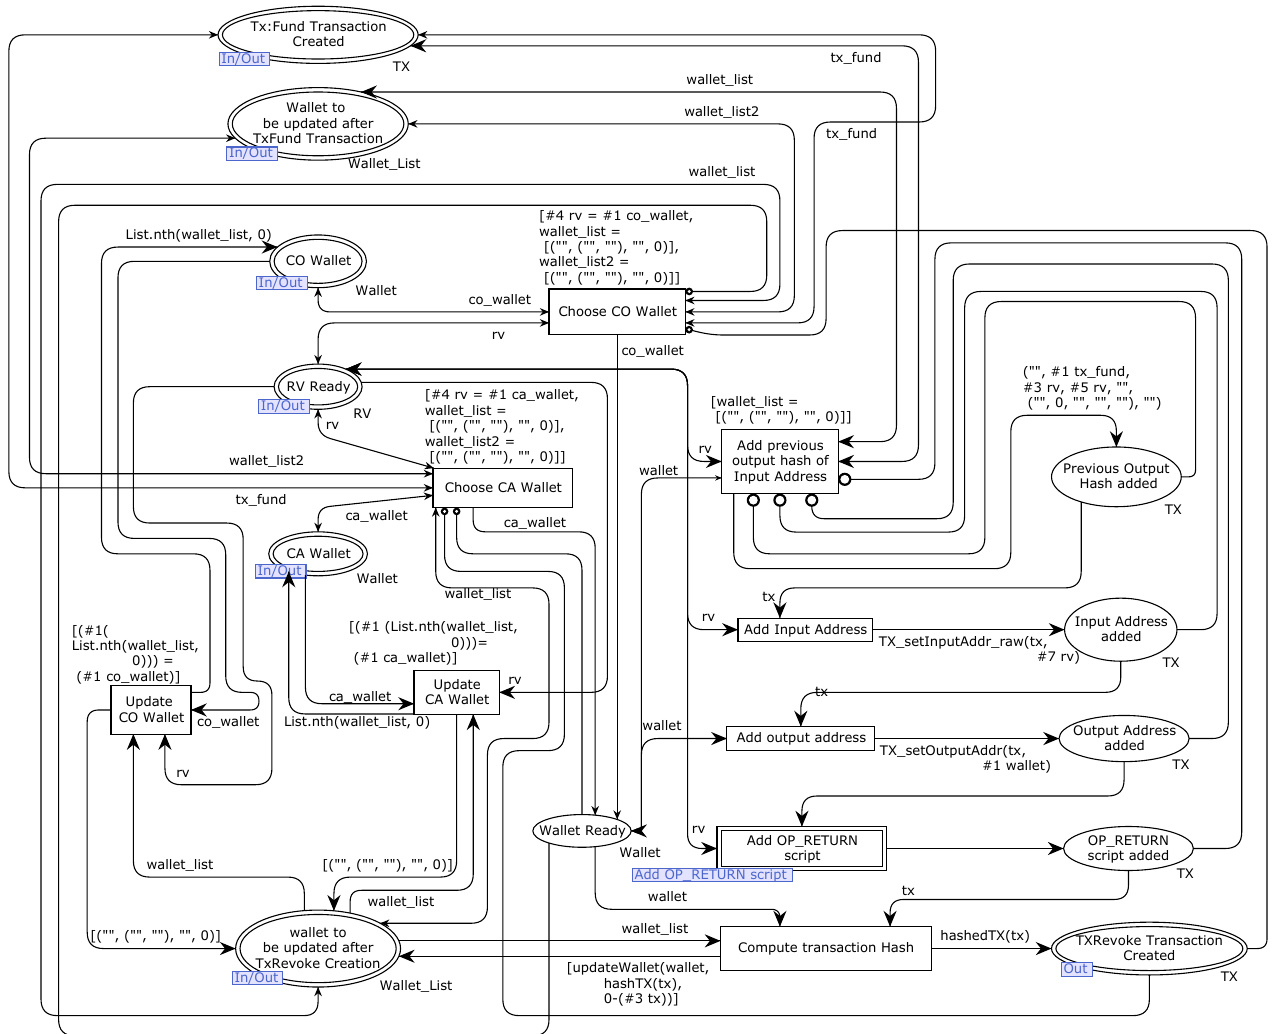
Figure 13. ‘Create Tx:Revoke Transaction’ sub-module of the BlockVoke CPN model.